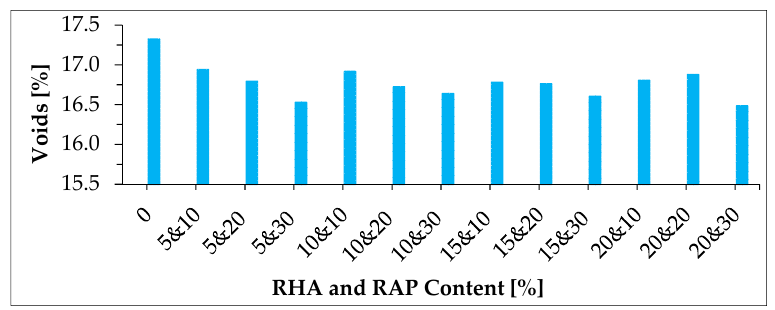
Figure 19. Void spaces in both RHA- and RAP-inclusive concrete.